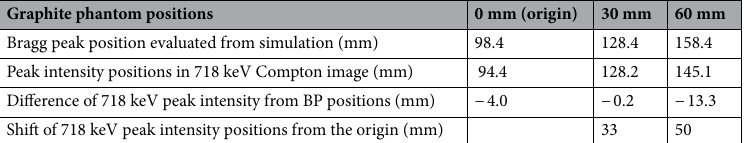
Graphite phantom